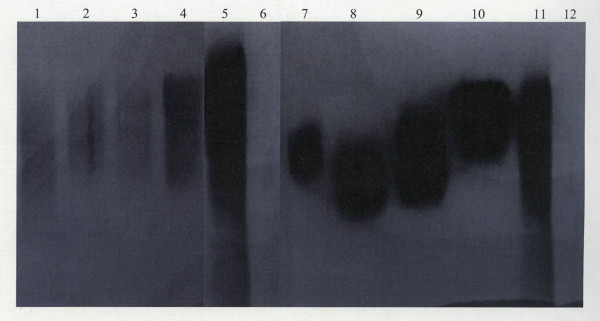
Western blotting of salivary MUC5B and MUC7 from HIV positive individuals with different CD4 counts. Lane 1, MUC5B from patients with CD4 > 400, lane 2, MUC5B from patients with CD4 200-400, lane 3, MUC5B from patients with CD4 < 200, lane 4, MUC5B from HIV negative individual, lane 5, crude saliva (positive control), lane 6, MUC7 (negative control), lane 7, MUC7 from patients with CD4 > 400, lane 8, MUC7 from patients with CD4 200-400, lane 9, MUC7 from patients with CD4 < 200, lane 10, MUC7 from HIV negative individuals, lane 11, crude saliva (positive control) and lane 12, MUC5B (negative control) were separated by a 1% agarose gel and transferred to nitrocellulose membrane. Following overnight blocking, the membranes were incubated for 2 h with rabbit anti-MUC5B polyclonal (lanes 1-6) and mouse anti-MUC7 monoclonal (lanes 7-12) antibodies diluted in 5% (m/v) low fat milk powder in TBST at 1 in 2000 (rabbit anti-MUC5B) and 1 in 1000 (mouse anti-MUC7). Membranes were then washed 3 × 5 min with TBST and incubated for 1 h with HRPO linked goat anti-rabbit (lanes 1-6) and goat anti-mouse (lanes 7-12) secondary antibodies diluted in 5% (m/v) low fat milk powder in TBST at dilutions of 1 in 5000 and 1 in 1500 respectively. After another TBST wash (3 × 5 min), bands were detected using an ECL detection kit.